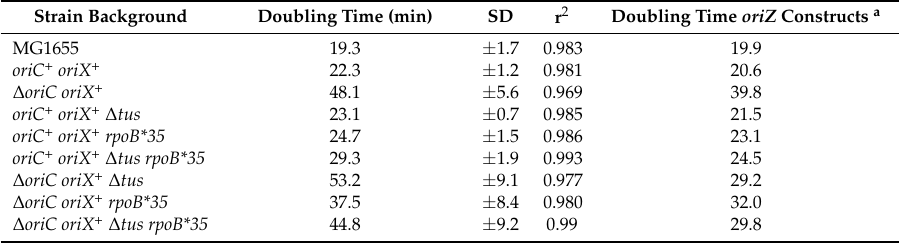
Table 2. Doubling times of E. coli strains with an ectopic replication origin in the left